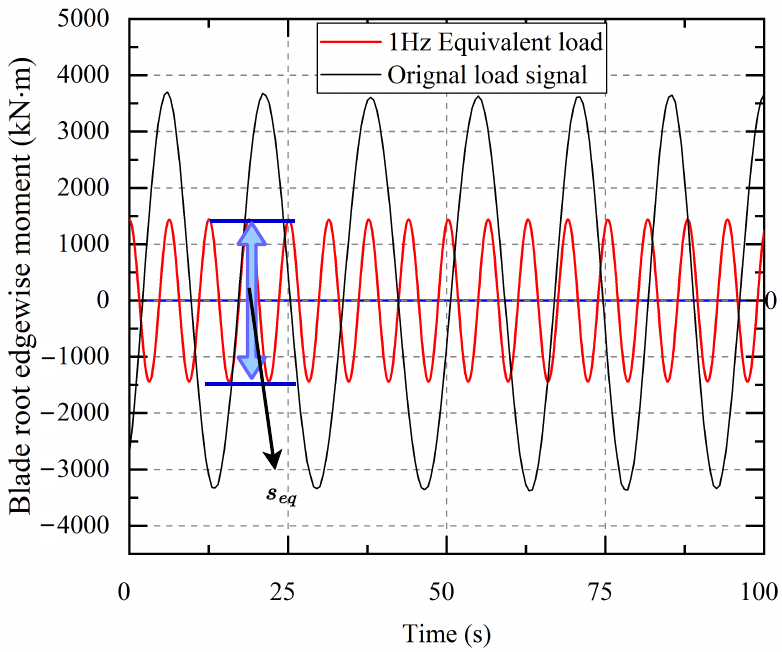
Figure 7. BREM orignal load signal and its 1 Hz equivalent signal under precursor P7.